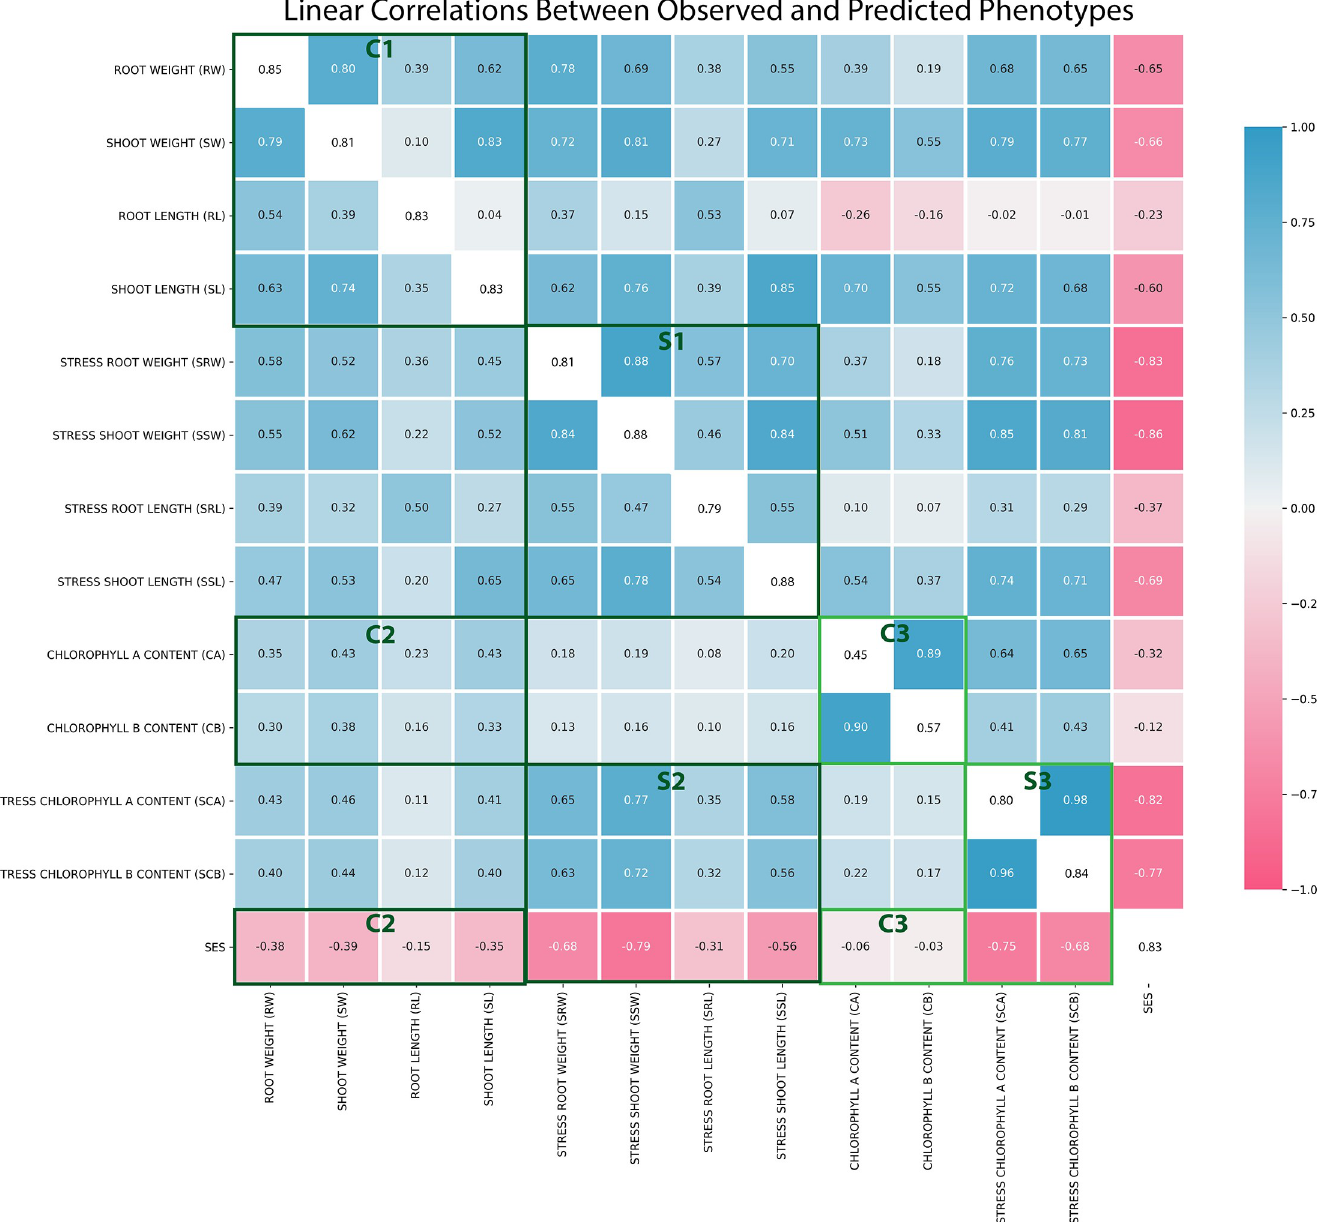
Fig 3. Linear correlations (r) between observed and predicted phenotypes. The bottom triangle of the white diagonal shows correlations between observed phenotype values and the top part is comprised of correlations between values estimated from genomic prediction. The white diagonal is the correlation between observed and predicted values for each phenotype. In the highlighted rectangles, C stands for control condition and S stands for stress condition. C1 to S1 and C2 to S2 depicts a fortification of linear correlation between biomass traits and SES when salt stress is imposed. C3 to S3 show the same trend for chlorophyll traits. C2 to S2 and C3 to S3 further show that the enhancement of linear correlation brought about by salt stress applies to SES as